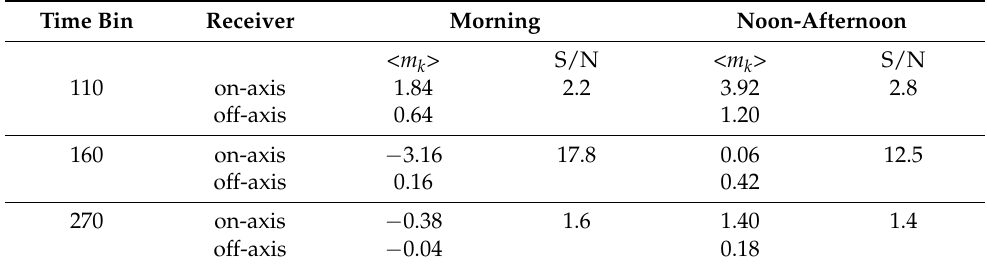
Table 3. Mean spectral slopes for different times of the day. < m k > arithmetic average of m k . Time Bin Receiver Morning Noon-Afternoon < m k > S/N < m k > S/N 110 on-axis 1.84 2.2 3.92 2.8 off-axis 0.64 1.20 160 on-axis − 3.16 17.8 0.06 12.5 off-axis 0.16 0.42 270 on-axis − 0.38